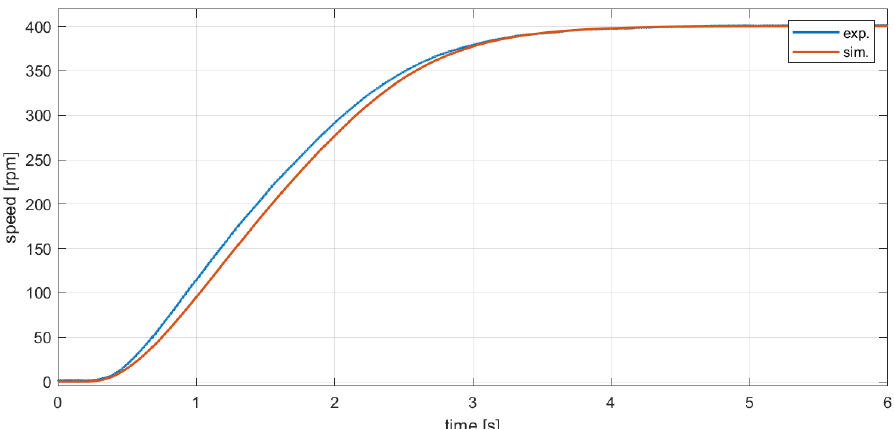
Figure 14. Measurement and result of simulation of the waveform of pressure on the motor 𝑝 (cid:3046) for the control signal rise time 𝑡 (cid:2868) = 1 s.